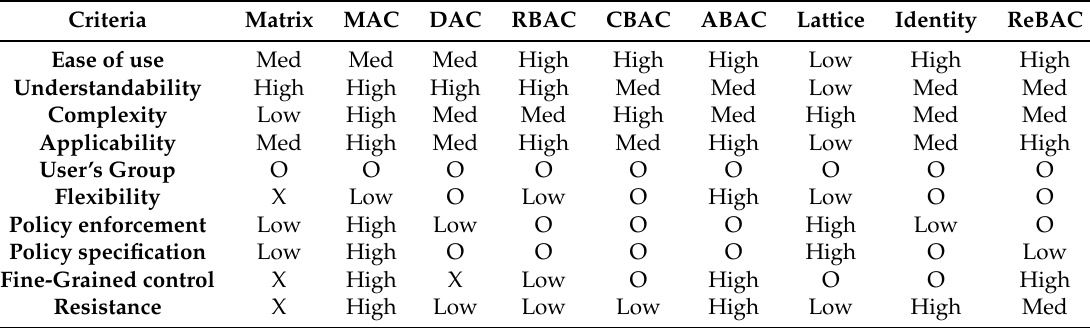
Table 2. Comparison between AC Models for the Internet of